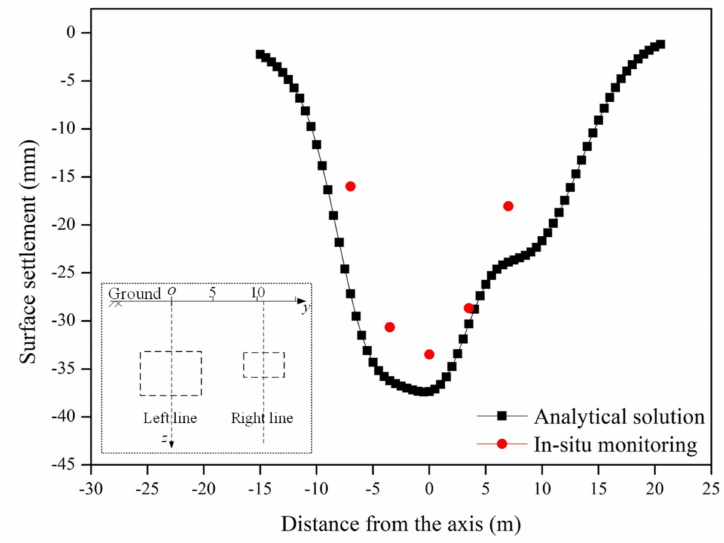
Figure 12. Curves of transverse ground surface